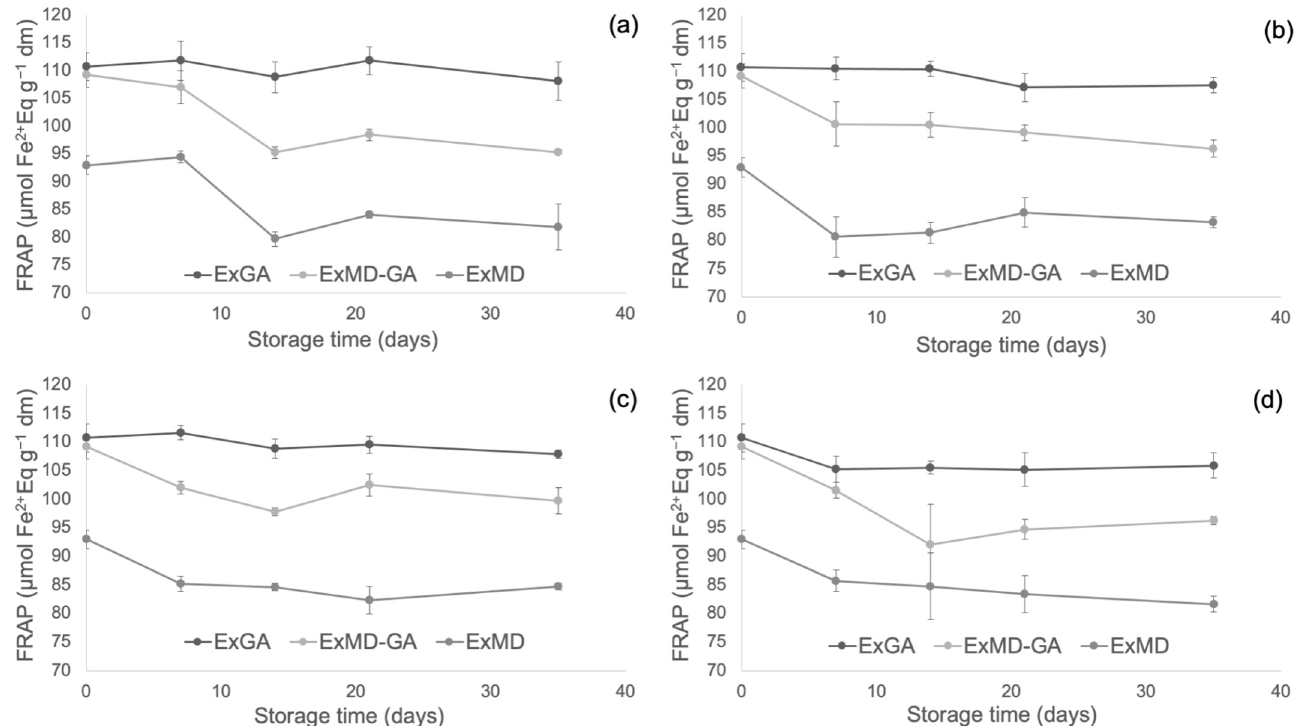
Figure 5. Ferric reducing antioxidant power (FRAP) of encapsulated hop extract during storage at different temperatures: 5 ◦ C ( a ), 20 ◦ C ( b ), 35 ◦ C ( c ), 50 ◦ C ( d ).